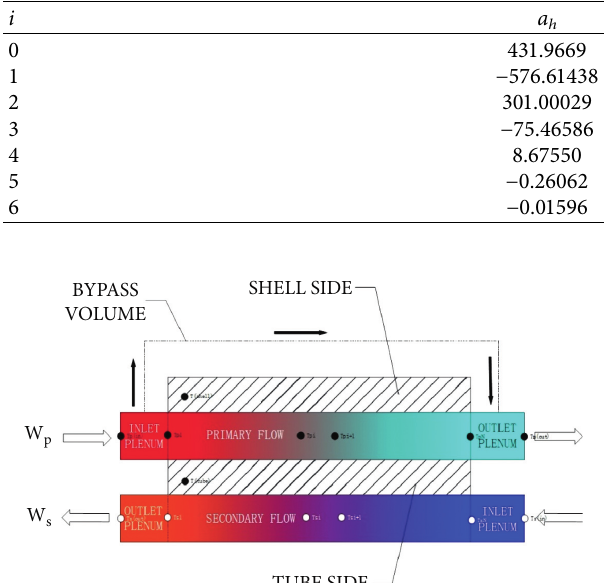
Table 4: Coefficients for the pump curve.